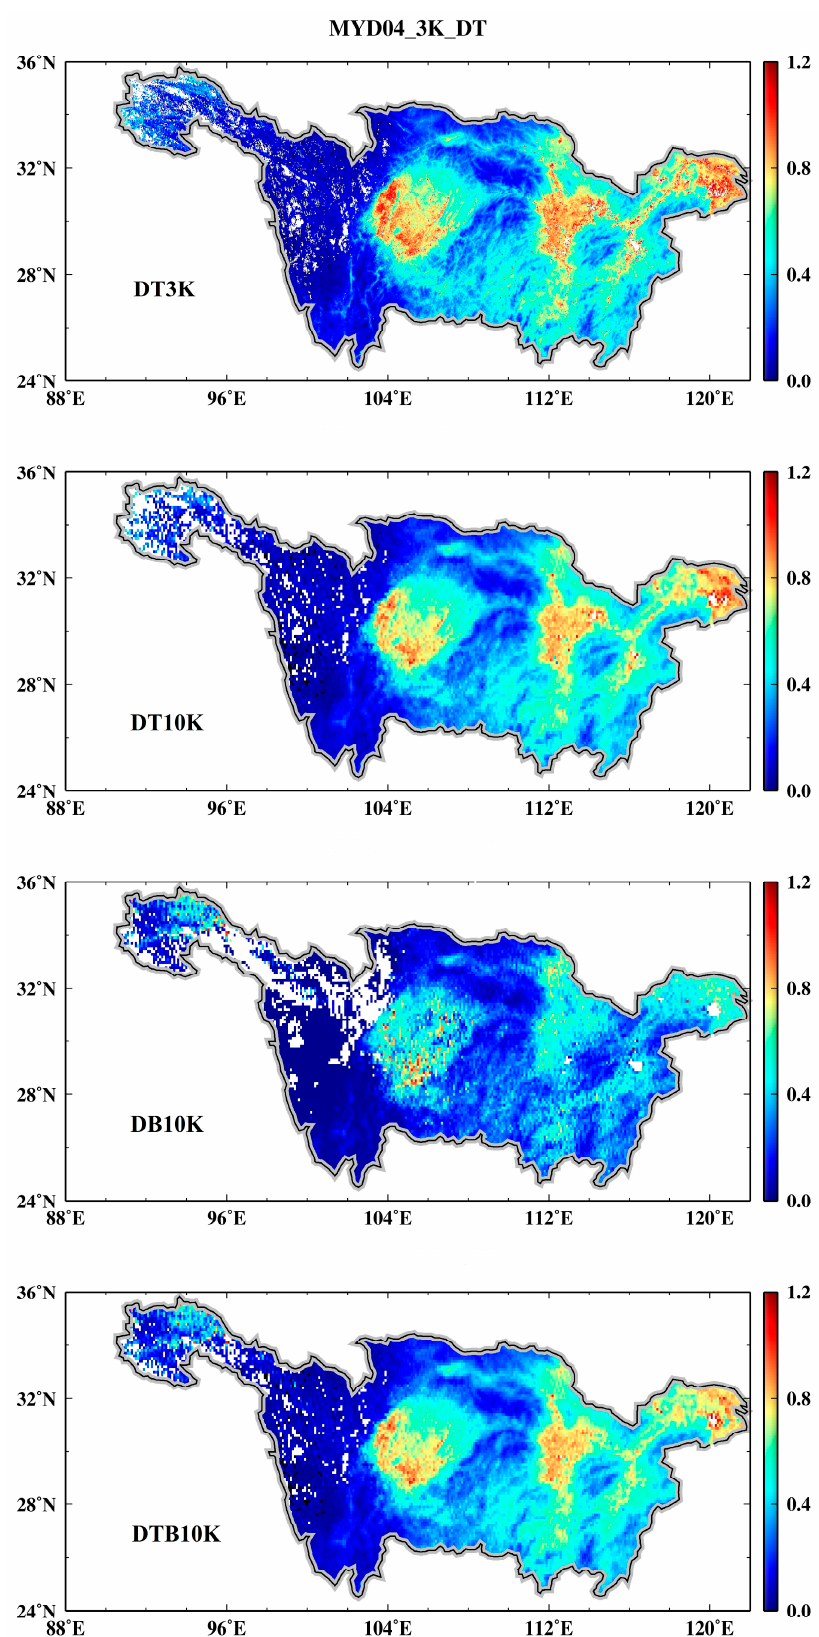
Figure2. As in Figure1, but for the aqua-MODIS C6 AOD products. Figure 14. As in Figure 13, but for the Aqua-MODIS C6 AOD